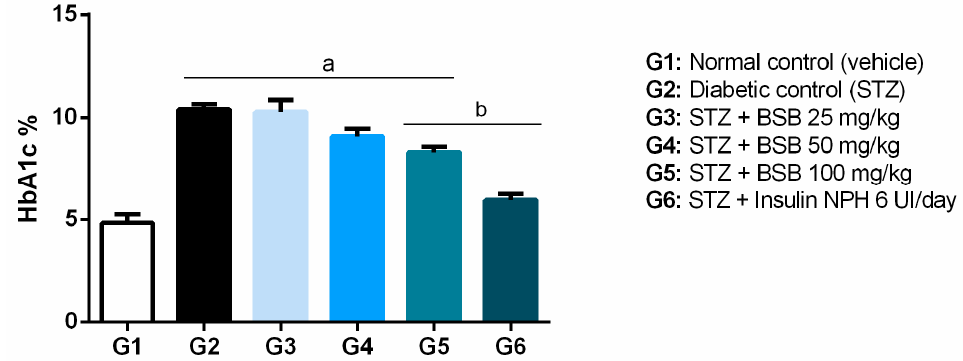
Figure 2. Percentages of glycated hemoglobin (HbA1C%) in STZ-induced diabetic rats treated with bacuri seed butter (BSB). a p < 0.05 vs. normal control; b p < 0.05 diabetic control; one-way ANOVA and Tukey’s post hoc test.